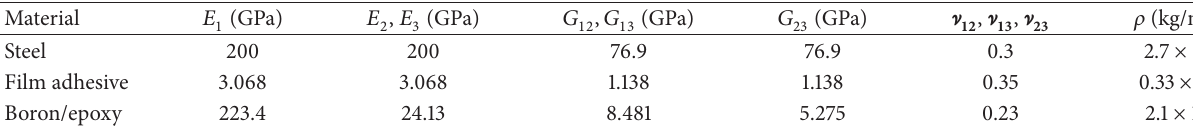
Table 2: Material properties.